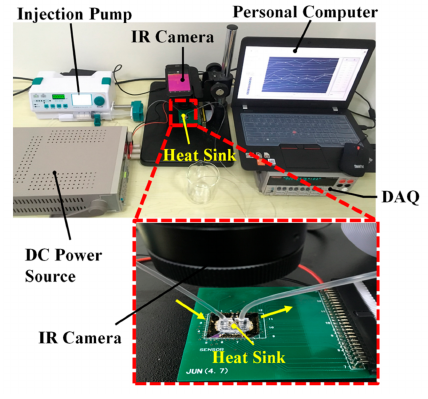
Figure 3. The physical picture of thermal testing system.